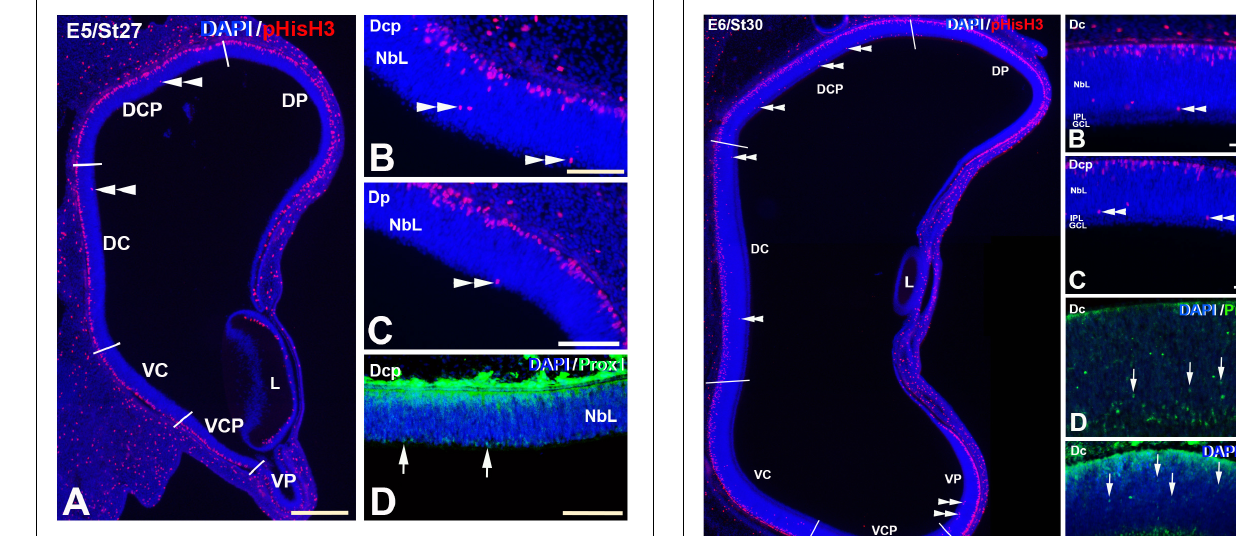
and T. guttata retina (Álvarez-Hernán et al., 2018,